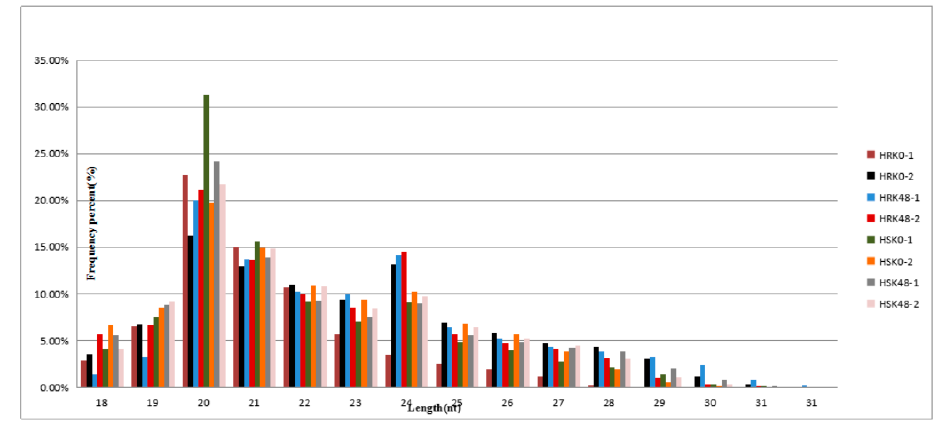
Figure 1. Length distribution of the small RNA.